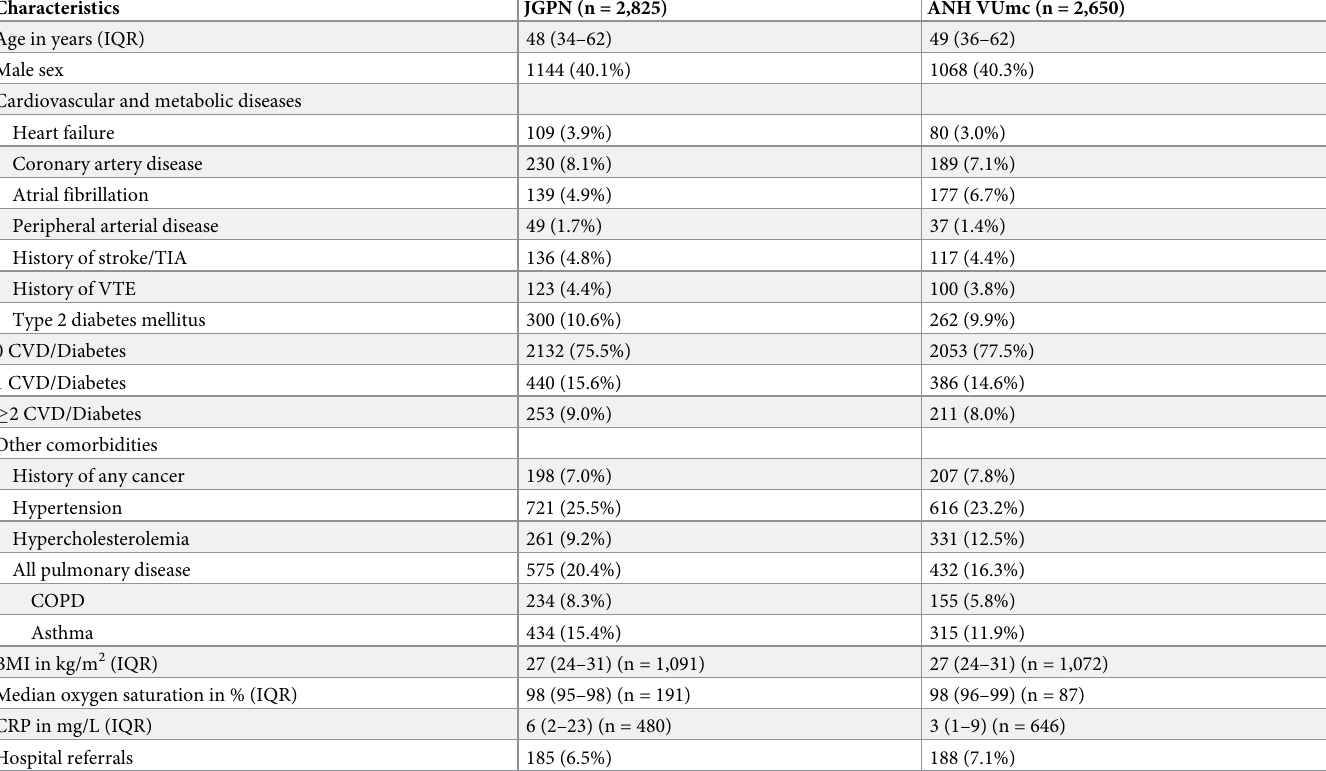
Table 1. Baseline characteristics of the development cohort of 5,475 community patients with confirmed or clinically suspected COVID-19 from the ‘first wave’ in the Netherlands.